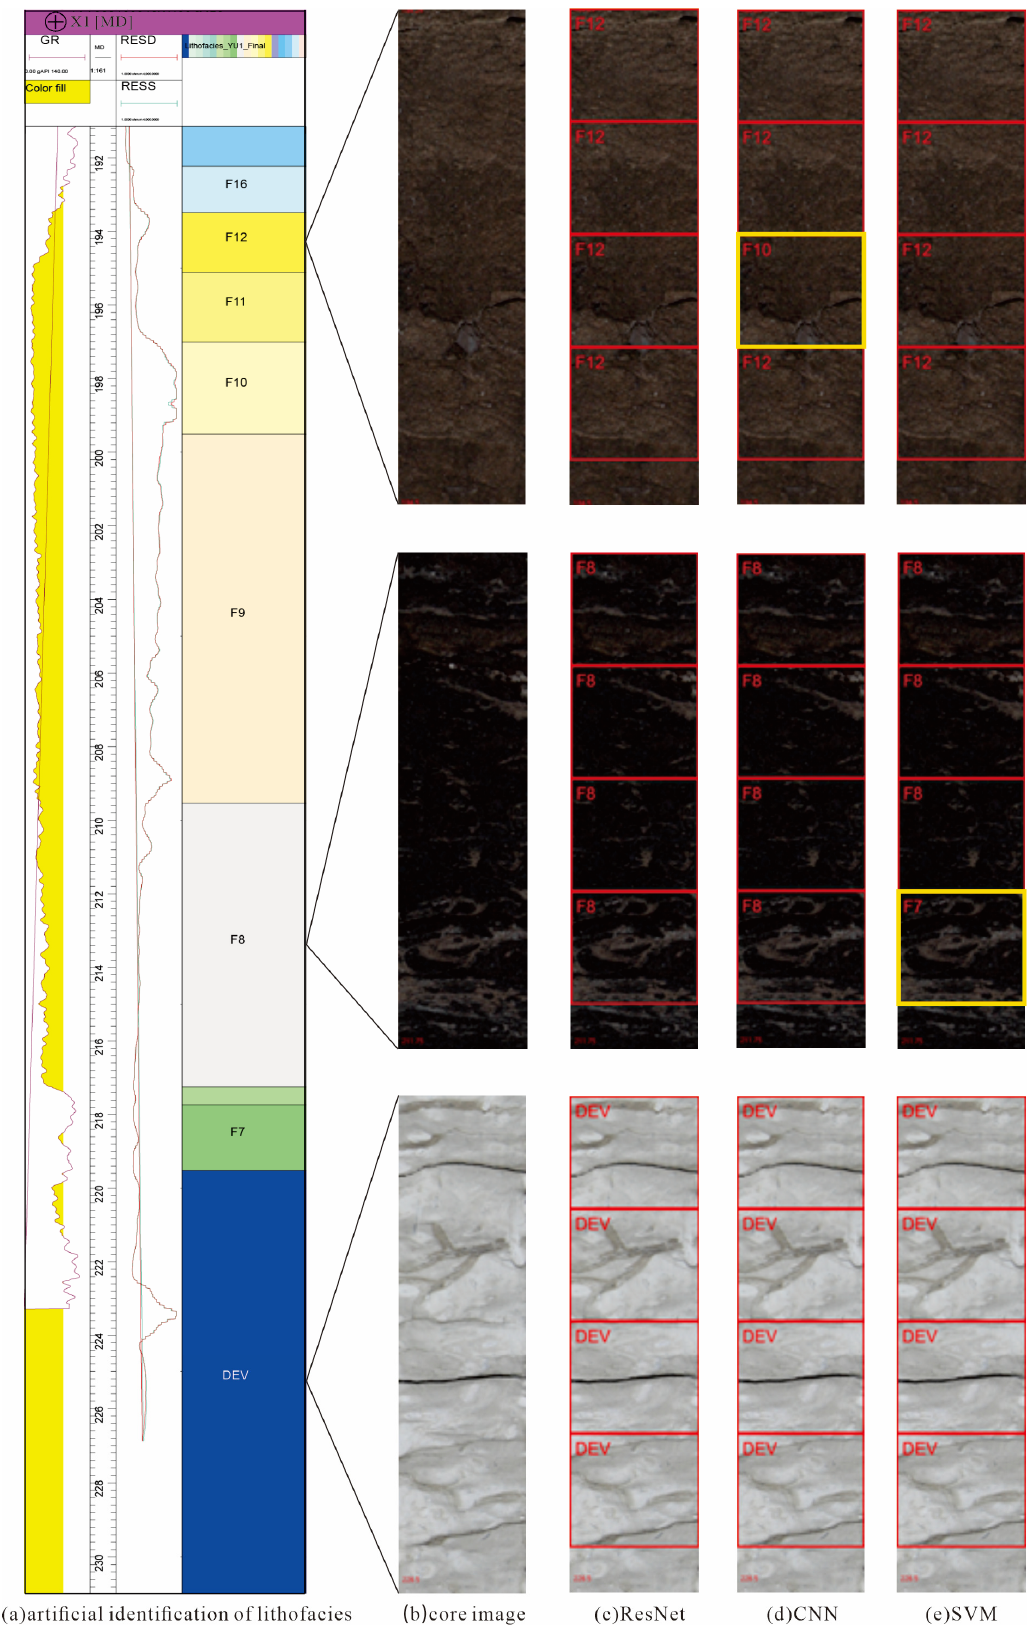
Figure 9. Core identification